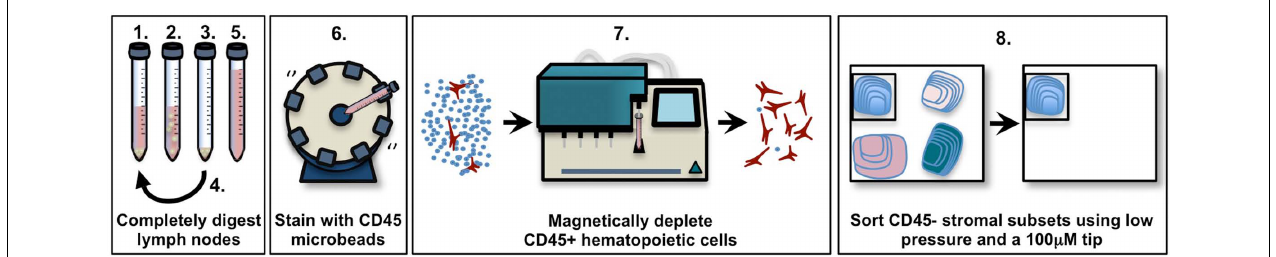
containing released cells, centrifuge it and store it on ice. 4. Repeat steps 1–3 until all fragments are fully digested (no more than 60min). 5. Pool all supernatant fractions, centrifuge, filter, and count. 6. Add anti-CD45 microbeads, incubate at 4˚C on rotating wheel. 7. Use MACS or AutoMACS to deplete CD45 + cells, count. 8. Stain enriched CD45 − stroma with antibodies; sort to high purity using 100 μ m tip at